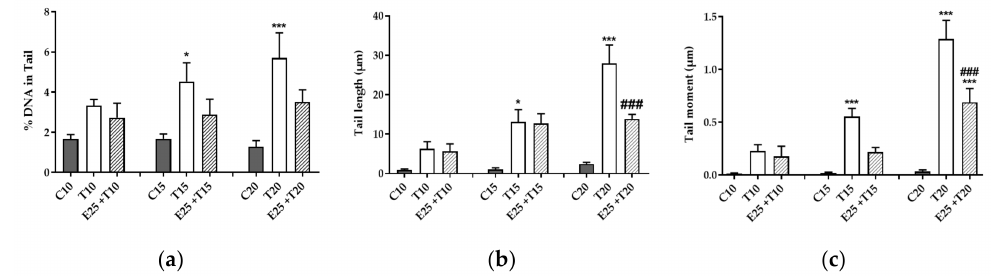
Figure 3. E ff ect of Rhus coriaria L. and UV-A rays on genotoxicity. Alkaline Comet assay evaluated DNA damage through ( a ) %DNA in Tail, ( b ) Tail length and ( c ) Tail moment (%DNA in Tail* Tail length). HMEC-1 cells were treated for 1 h with 25 µ g / mL of mERC (E25) and exposed to 10, 15 or 20 J / cm 2 UV-A (T10, T15, T20). Results are expressed as mean of medians ± SEM, n = 6. Statistical analysis: One-Way ANOVA with Bonferroni’s post hoc analysis. * p < 0.05, *** p < 0.001 vs. C PBS, ### p < 0.001 vs. T20.